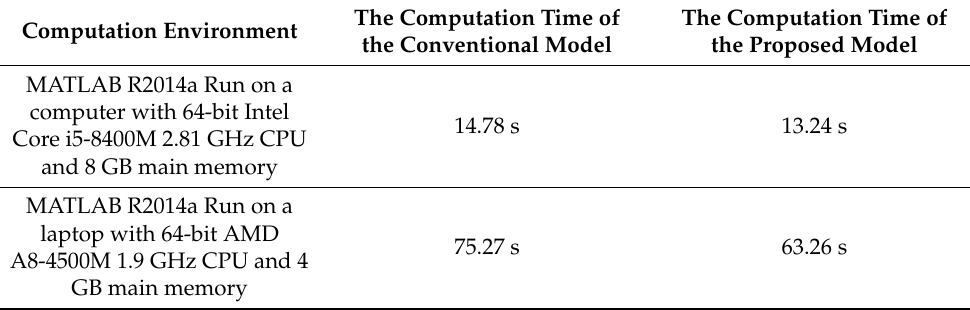
Table 6. Comparison of the computation efficiency of two optimization